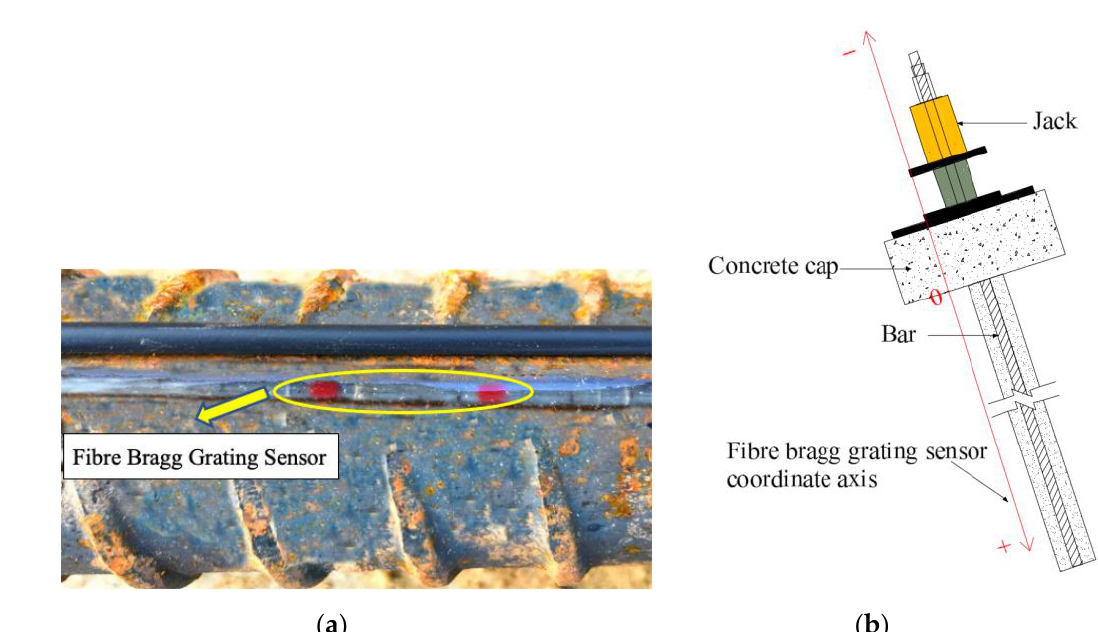
Figure 4. Installation of the Fibre Bragg Grating Sensor. ( a ) Position of Fibre Bragg Grating Sensor ( b ) Coordinate axis of Fibre Bragg Grating Sensor.